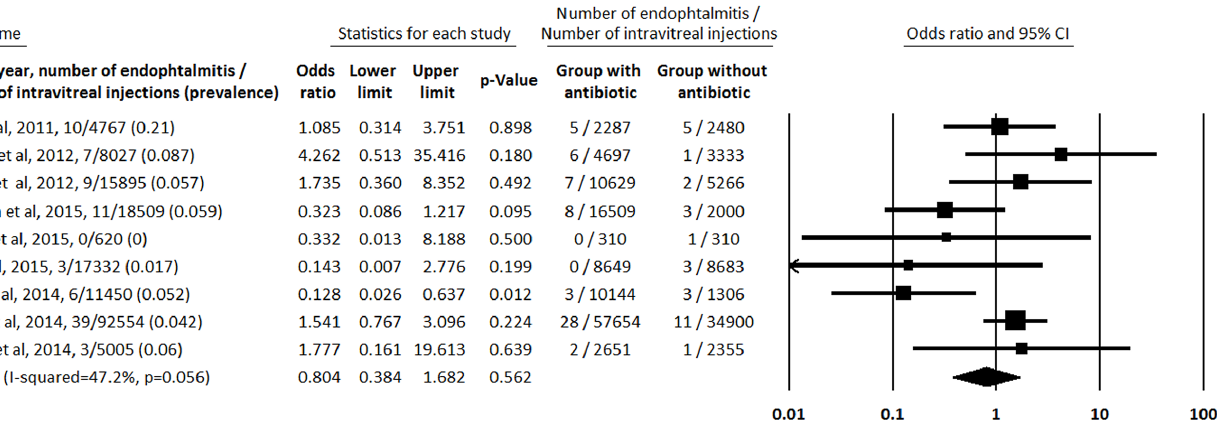
Fig 2. Odd ratio for each study including both culture-proven and culture negative endophthalmitis.